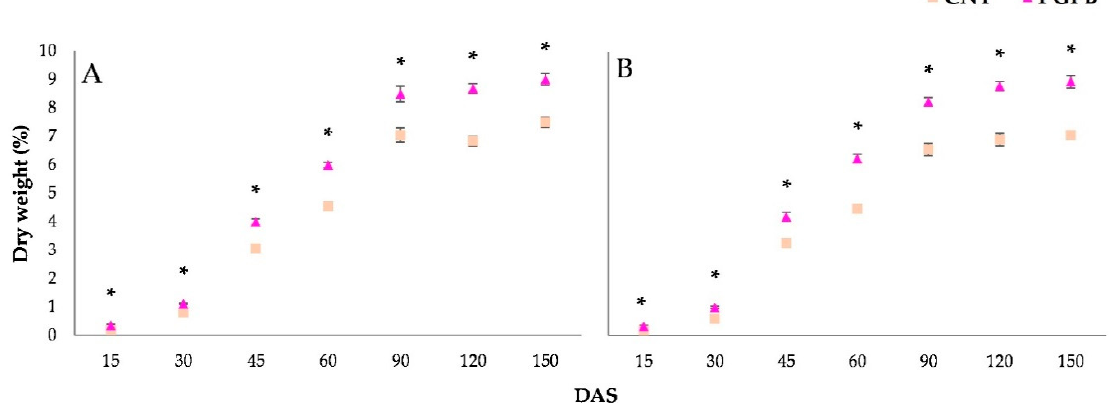
Figure 2. Height dynamics recorded for Meranto ( A ) and Moondance ( B ). In the figure: CNT = Control; PGPB = treated seed; DAS = days after sowing; * = p < 0.001.